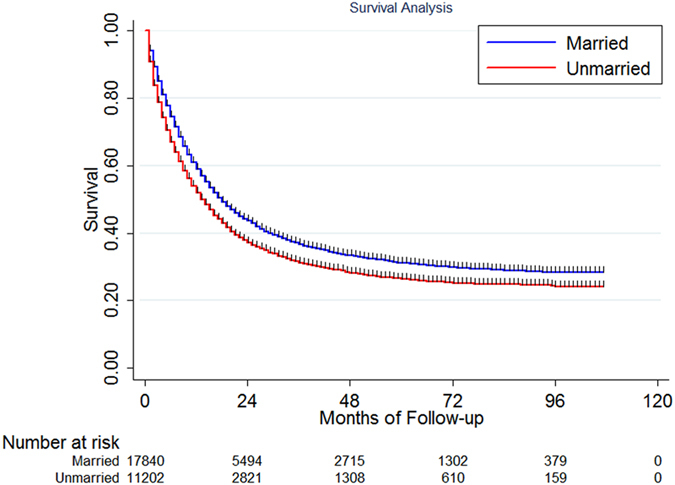
The survival difference between married and unmarried patients.